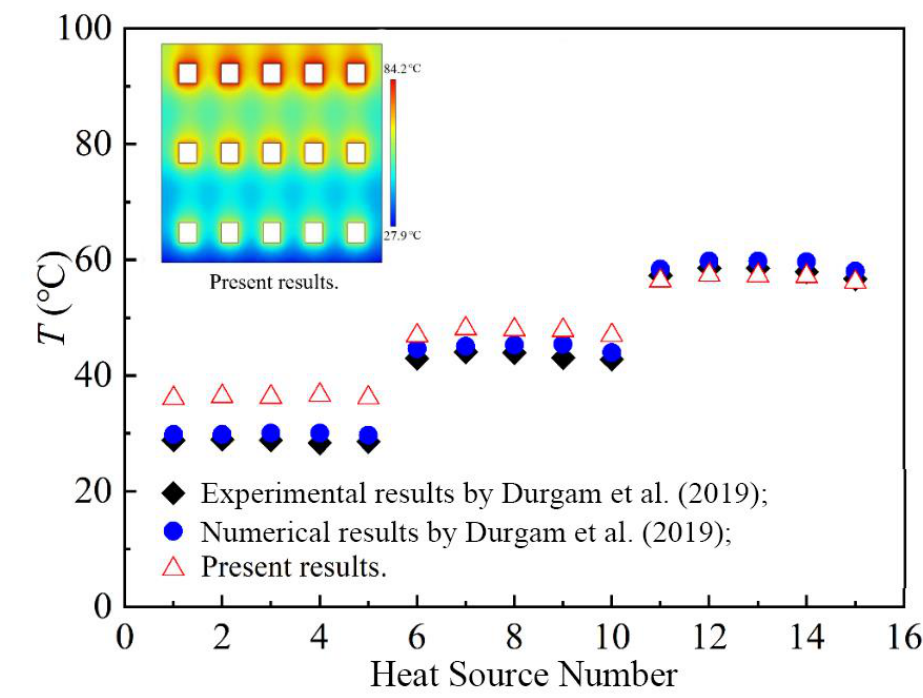
Figure 2. Temperature distribution and average temperature of the FR4 substrate obtained by Shankar Durgam et al. [25] and present results.